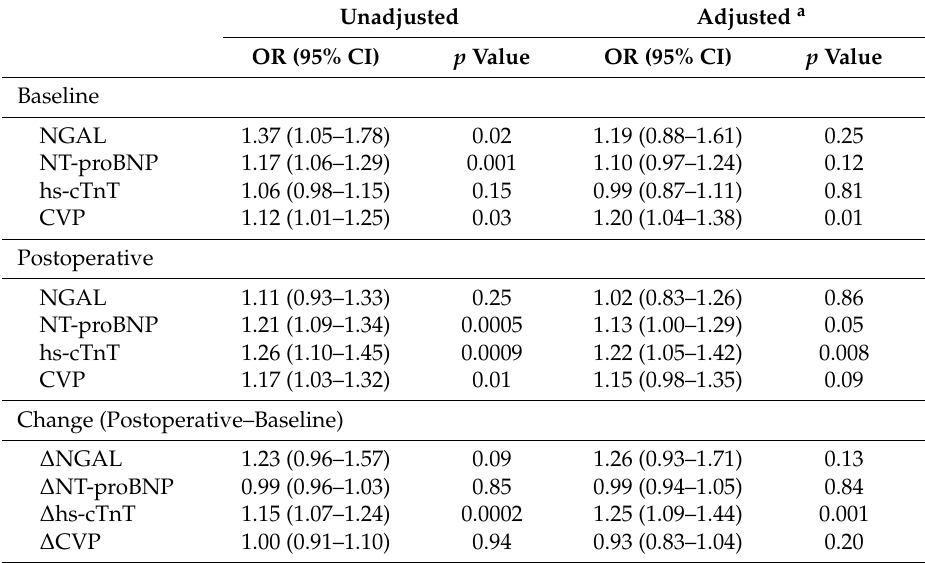
Table 2. Association between cardiorenal biomarkers and congestive acute kidney injury.